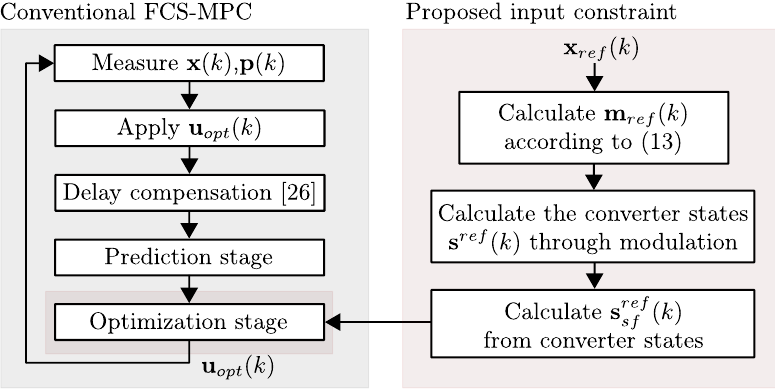
Figure 3. Proposed FCS-MPC. Red boxes indicate new or modified